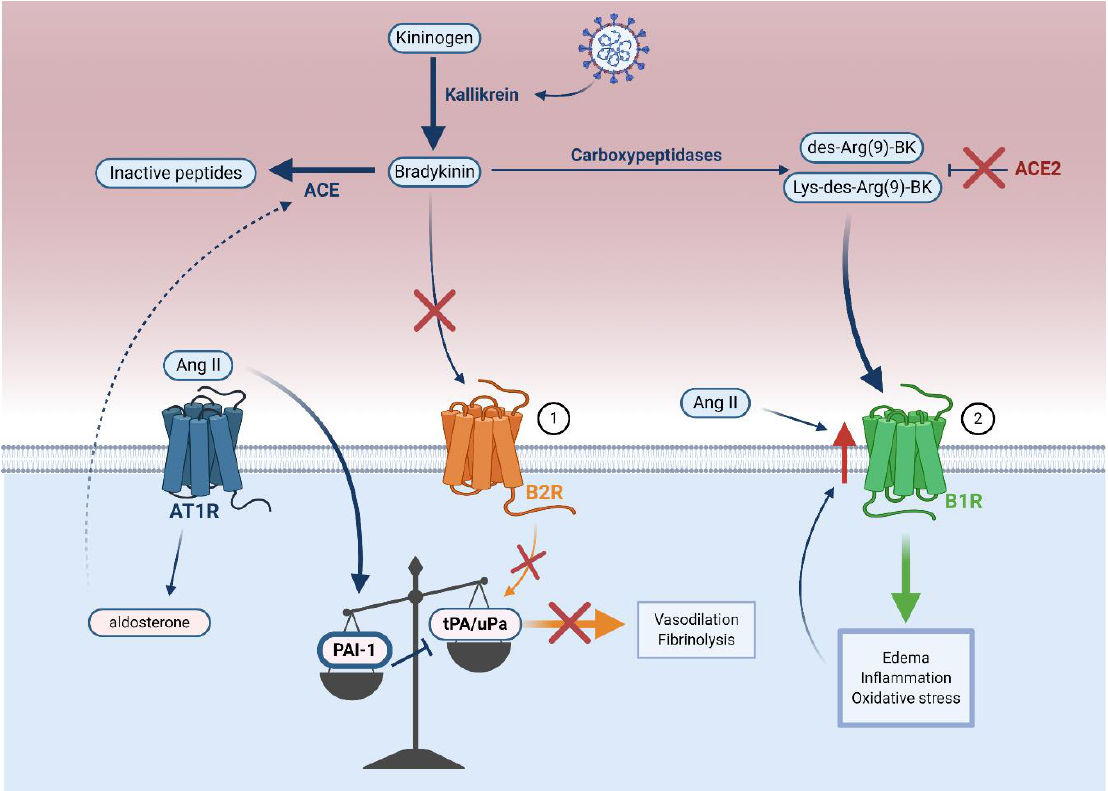
Figure 4. SARS-CoV-2-mediated cellular ACE2 downregulation leads to bradykinin – kallikrein pathway dysfunction. (1) In normal conditions, kallikrein converts kininogen to bradykinin, which can then bind to B2R on endothelial cells. B2R stimulation increase tPA/uPA to mediate protective vasodilation and fibrinolysis. (2) During SARS-CoV-2 infection, increased activity of kallikrein increase bradykinin. However, ACE2 downregulation increases Ang II. Ang II can convert bradykinin to its inactive peptides through aldosterone-induced ACE expression and increase PAI-1, which inhibits the protective effects of tPA/uPA. Furthermore, ACE2 downregulation prevents the inactivation of des-Arg(9)-BK and Lys-des-Arg(9)-BK. These can bind to endothelial B1R to promote detrimental vascular effects, which together with Ang II, upregulate B1R. In all, inhibition of B2R and stimulation of B1R results in hypofibrinolysis and adverse vascular conse- quences.